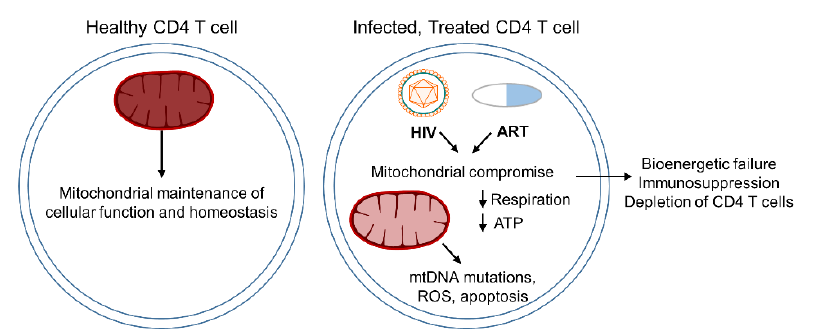
Figure 3. Summary of T cell deficiency in mitochondrial function and premature aging. HIV-infection significantly impairs mitochondrial function with respect to ∆Ψ m , respiration, ATP synthesis, mtDNA replication, and apoptosis. Each of these factors contributes to immunosuppression, depletion of CD4 + T cells, and premature aging in PLHIV.